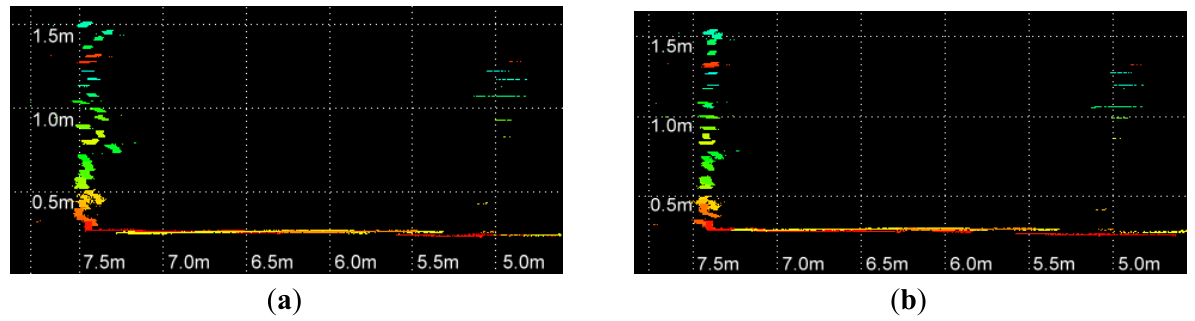
Figure 10. Scan of a wall ( a ) before recalibration; ( b ) after recalibration.